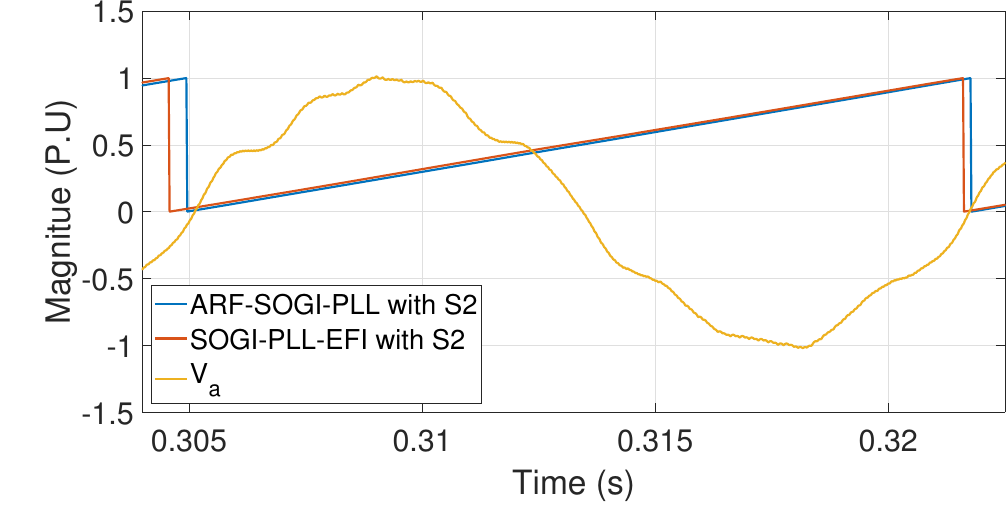
Table 4. Required memory and processing time of each algorithm in the